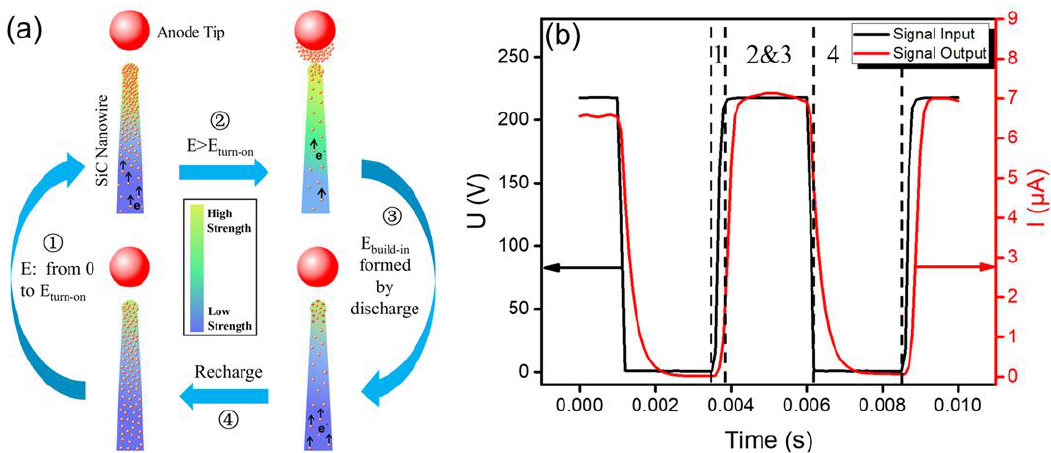
Figure 5. ( a ) Schematic illustration of electron emission and pumping-like electron recharge process of SiC nanowire in pulsed driving mode. ( b ) The schematic U&I-Time picture showing the corresponding cycle processes related to those indicated in (a).